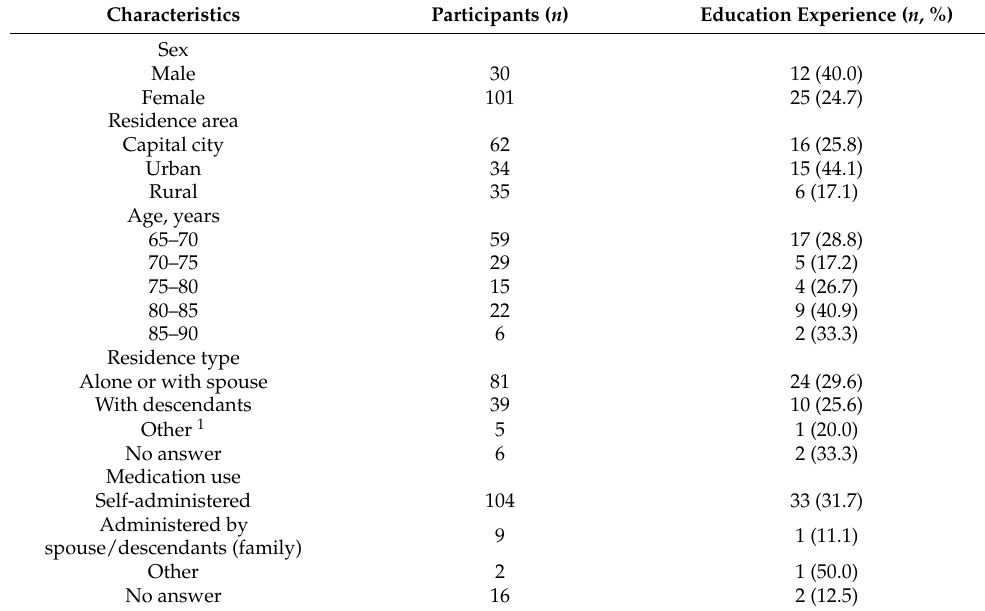
Table 1. Demographic characteristics ( n = 131).